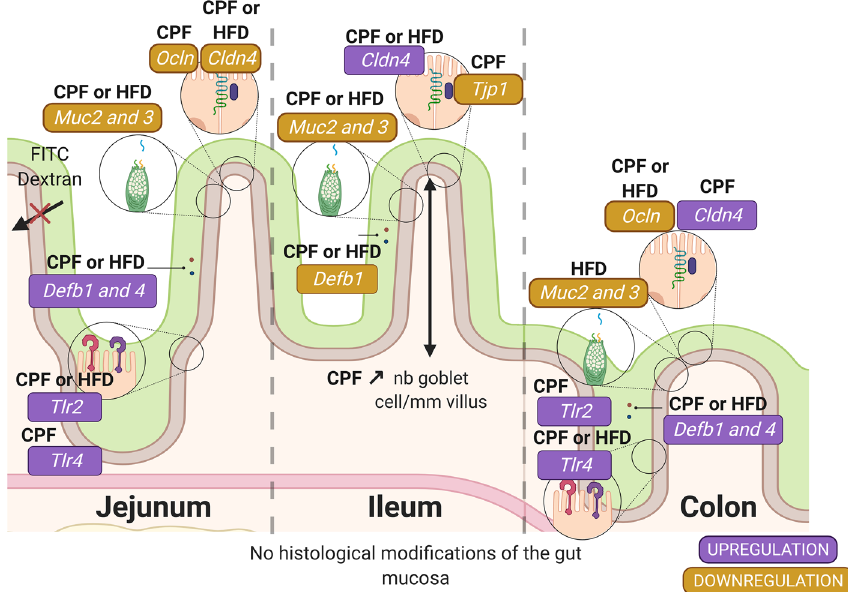
Figure 9. Effect on intestinal barrier in progeny from mothers submitted to CPF in the absence or presence of HFD. Created with BioRender.com; CPF Chlorpyrifos, HFD high fat diet, Cldn4 Claudin 4, Defb1 Defensin β1, Defb4 Defensin β4, Muc1 Mucin 1, Muc2 Mucin 2, Muc3 Mucin 3, Ocln Occludin, Tjp1/Zo-1 Zonula occludens-1, Tlr2 Toll Like Receptor 2, Tlr4 Toll Like Receptor